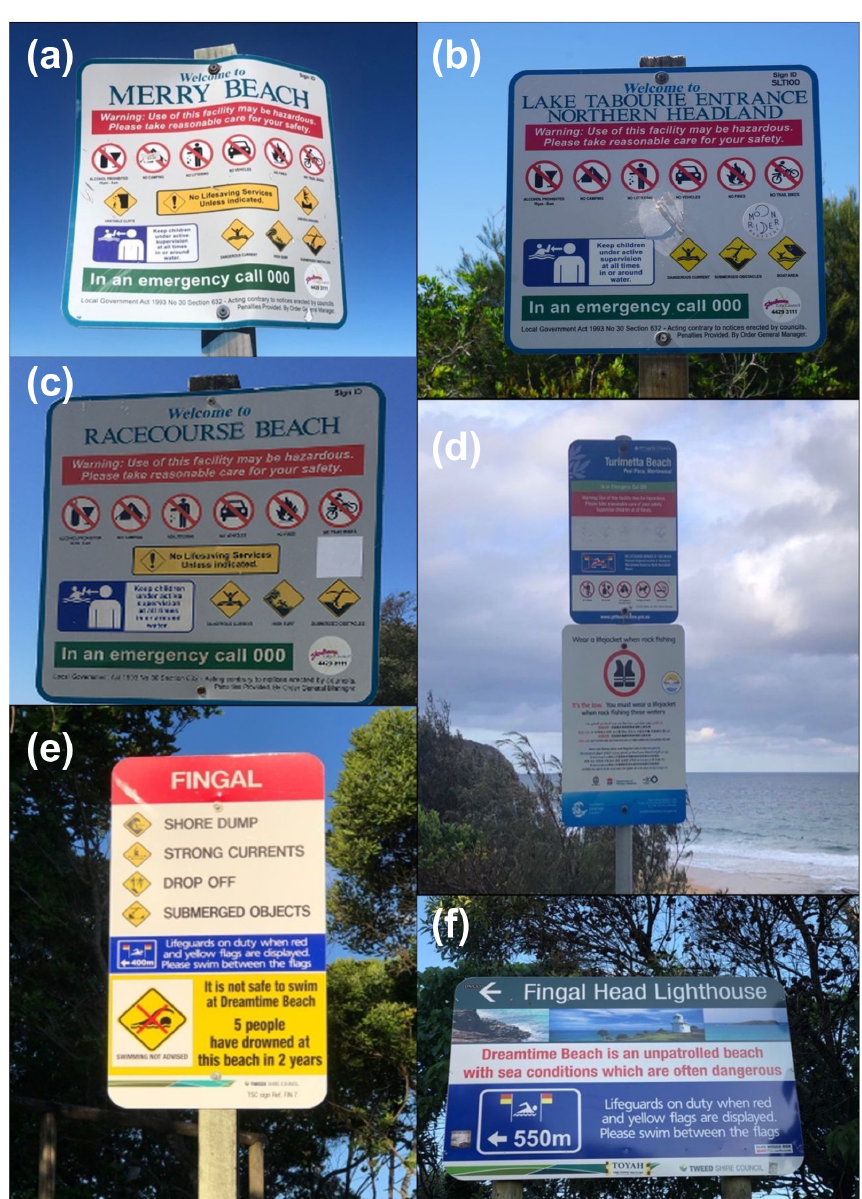
Figure 4. Beach safety signs at: (a) Merry Beach; (b) Tabourie Beach; (c) Racecourse Beach; (d) Turimetta Beach; (e, f) Dreamtime Beach. (a) – (c) were the South Coast beaches. Photos courtesy of Lea Uebelhoer (a–c) , William Koon (d) , Robert W. Brander (e, f)